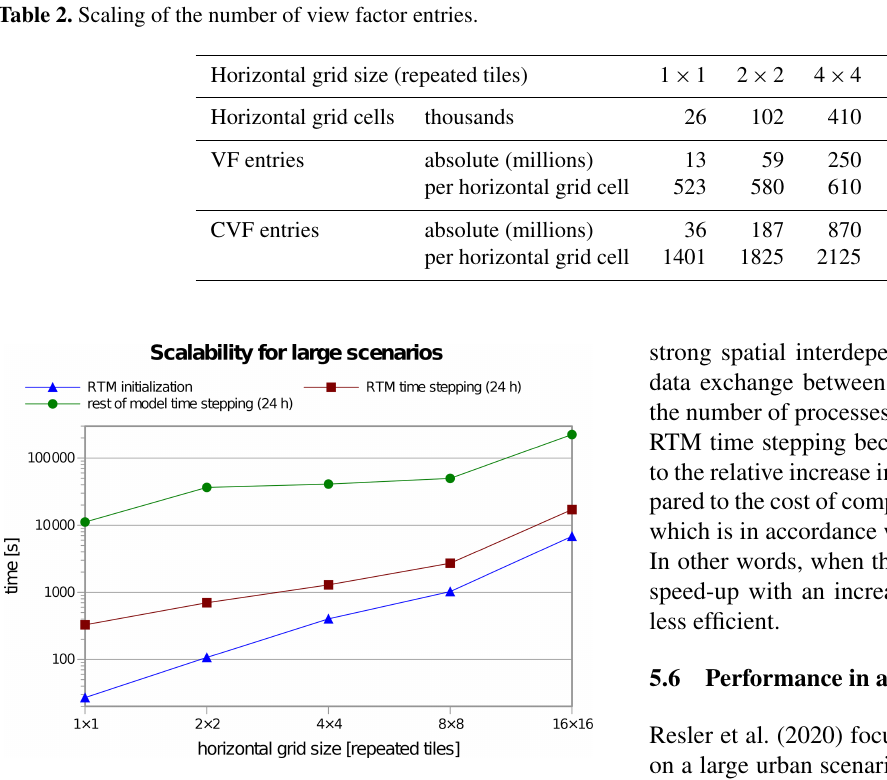
Figure 9. A double-logarithmic presentation of the computation time spent for different sub-tasks while simulating progressively larger domains (by the means of horizontal quadruplication). Each simulation uses a constant number of processes per horizontal tile. The sub-tasks shown are RTM initialization and time stepping along with time stepping of the rest of the model as a reference. Time- stepping time is shown for a 1d long simulation as extrapolated from the 10min test simulations.